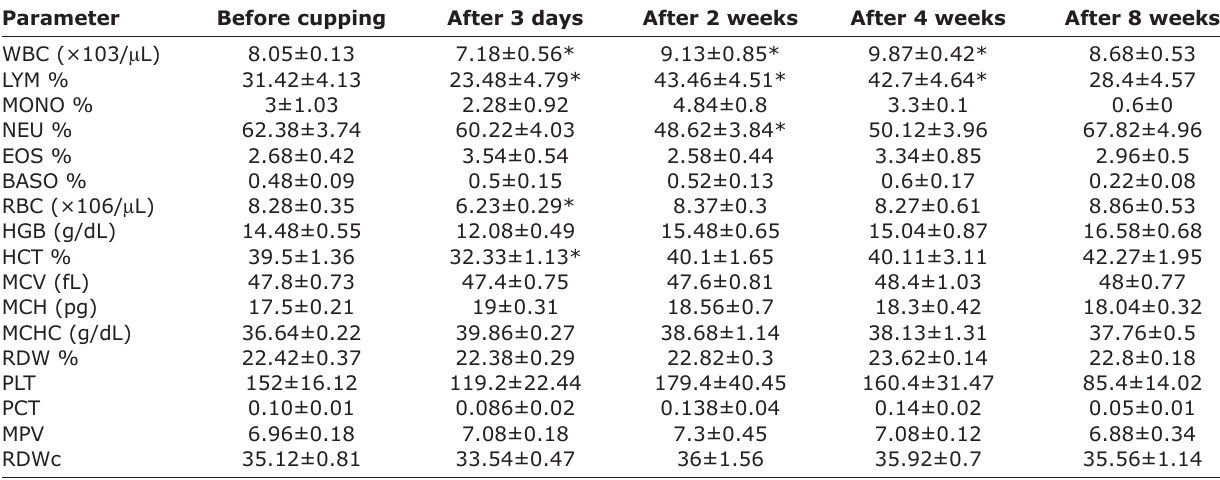
Table-1: Mean and SEM of the hematological parameters in Arabian horses before and after cupping. Parameter